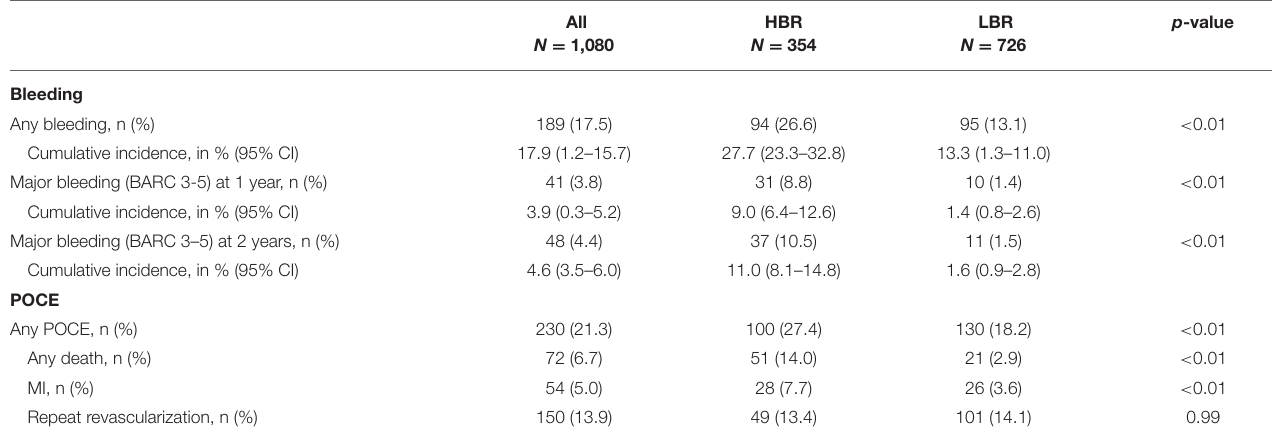
TABLE 4 | Clinical outcome at 2-year follow-up.